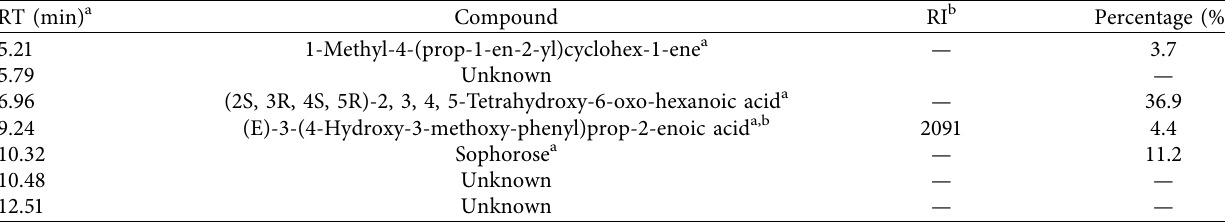
Table 3: GC-MS analysis results of the sugar beet pulp extract.